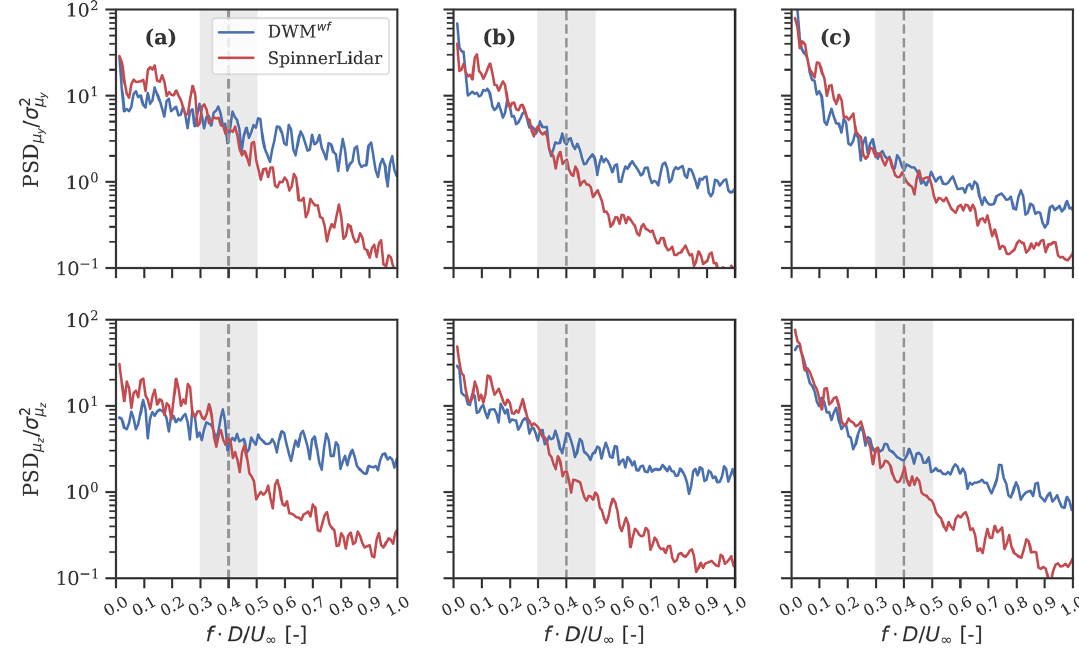
Figure 12. Normalized ensemble-average power spectral density (PSD) of the lateral and vertical wake meandering tracked by the Spinner- Lidar (red) and that derived using the meandering model (DWM wf ; shown in blue) under stable (column a ), near-neutral (column b ), and unstable conditions (column c ). The ensemble-average PSDs are computed for data collected at 2.5 D behind the rotor and are normalized with their relative variances. The 95% confidence interval in the large-scale-eddy definition is shown by the grey area (see text for more details). Table 4. Mean ( µ ), standard deviation ( σ ), and coefficient of variation (COV = σ/µ ) estimated from the posterior PDFs of model parameters. The values of k 1 , k 2 , σ (cid:15) , k m1 , k q 1 , k m2 , k q 2 , and σ (cid:15) are determined using Bayesian inference. D m denotes the spatial size of the large- def add scale eddies governing wake meandering dynamics, and y m ,(cid:15) and z m ,(cid:15) denote the wake tracking position errors expressed in metres. Modules Wake deficit Wake-added turbulence Wake meandering k 1 k 2 σ (cid:15) k ∗ k ∗ k ∗ k ∗ σ (cid:15) D m y m ,(cid:15) [m] z m ,(cid:15) [m] q 1 q 2 m1 m2 def add µ 0.081 0.015 σ 0.017 0.001 COV 21% 19% 5% 10%